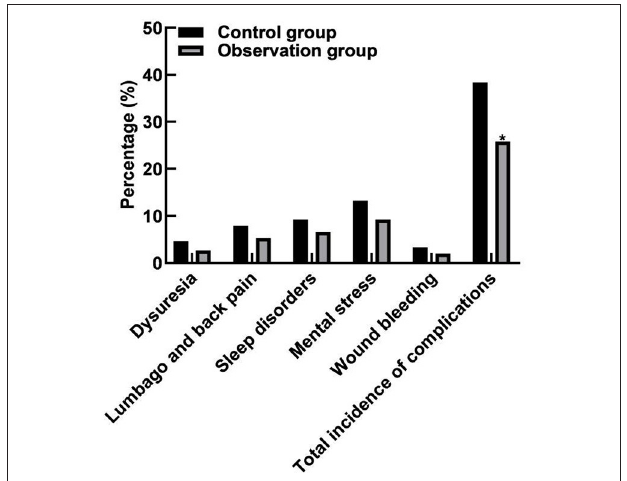
FIGURE 4 | Comparison of complications between the two groups. Compared with the control group, * p < 0.05.